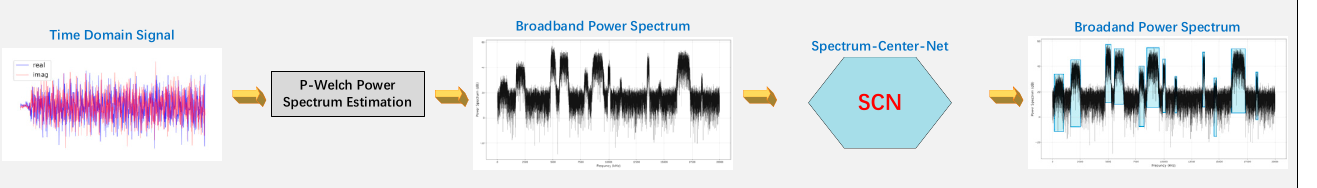
Figure 2. The detection process of the carrier signal detection in broadband power spectrum. The whole process mainly includes two steps. First, the Welch power spectrum estimation method is utilized to estimate the broadband power spectrum. Then, the proposed SCN regresses the FC and the corresponding BW of all the subcarriers of the broadband power spectrum.